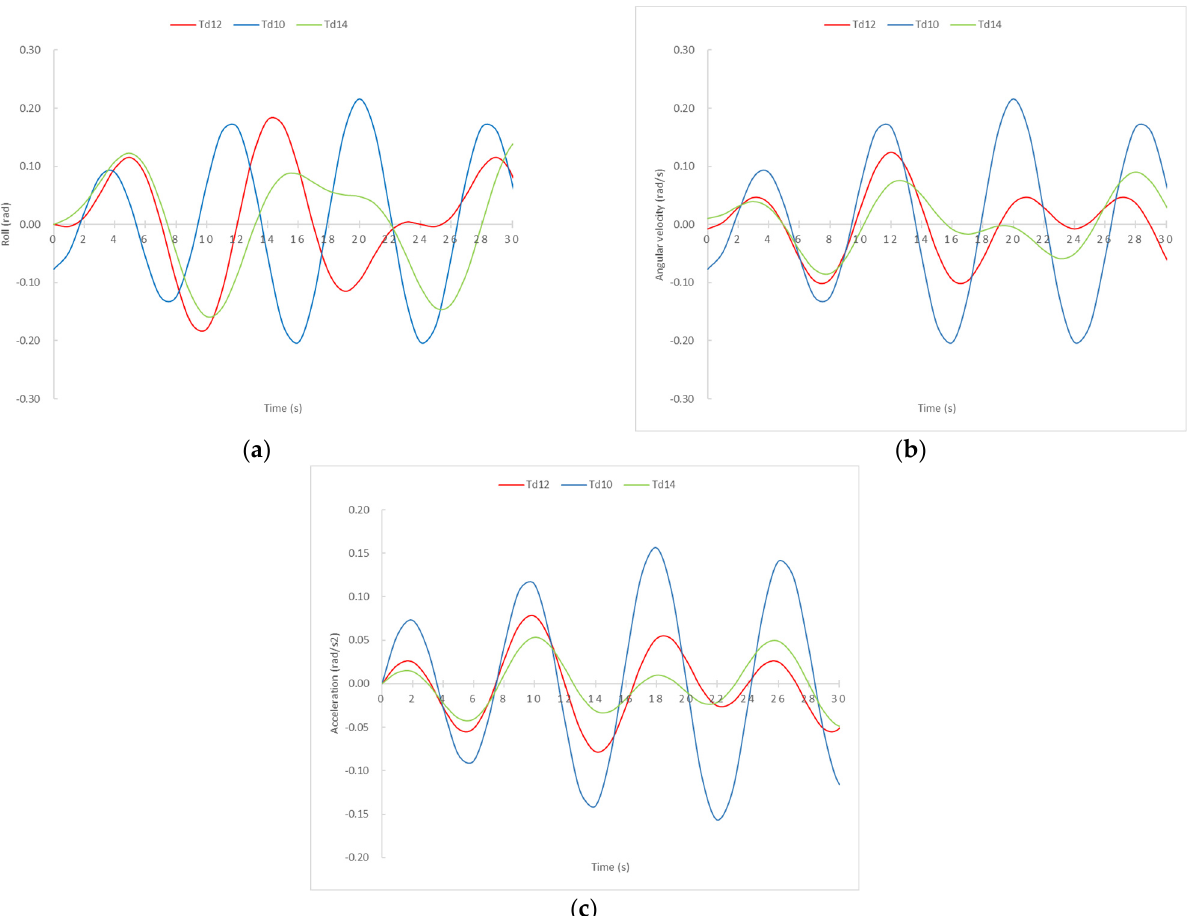
Figure 6. Rolling angle ( a ), velocity ( b ) and acceleration ( c ) of a ship with different loading conditions (Td = 10, 12 and 14 s) sailing in waves of T w = 8 s.